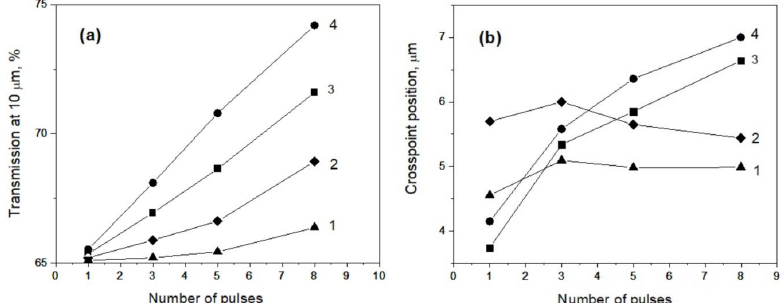
Figure 9. ( a ) The transmission at a wavelength of 10 µ m for GaSe with ARMs inscribed at different pulses of energies: 5.8 nJ (1), 8.4 nJ (2), 15.8 nJ (3), and 23.4 nJ (4) and numbers of pulses: 1, 3, 5, and 8. ( b ) The cross-point wavelength in the transmission spectra of the initial GaSe and GaSe with ARMs inscribed at the same experimental parameters. The maximal transmission in the mid-IR of the GaSe sample with an ARM was ob- tained at pulses energy of 37.5 nJ. Figure 10 shows the transmission spectra at different numbers of pulses N = 1, 3, 5, and 8, in the case of ARM inscription on both sides of the GaSe sample. Thus, at a pulse energy of 37.5 nJ and number of pulses at N = 8, the transmission increase of the ARM inscribed on one side was 15% (at wavelength of 12 µm) and 30% in the case of the ARM inscribed on both sides of the GaSe sample, resulting in a transmission of up to 94% (Table 1). Unfortunately, the maximal transmission was achieved at a certain wavelength of 12 µm, while the transmission decreased at shorter and longer wavelengths. The possibility of further increasing the transmission and shifting the crosspoint to the short wavelength was supposed to be possible by reducing the ARM period and the changing of crater shapes by using shorter laser wavelength and tight focusing conditions.